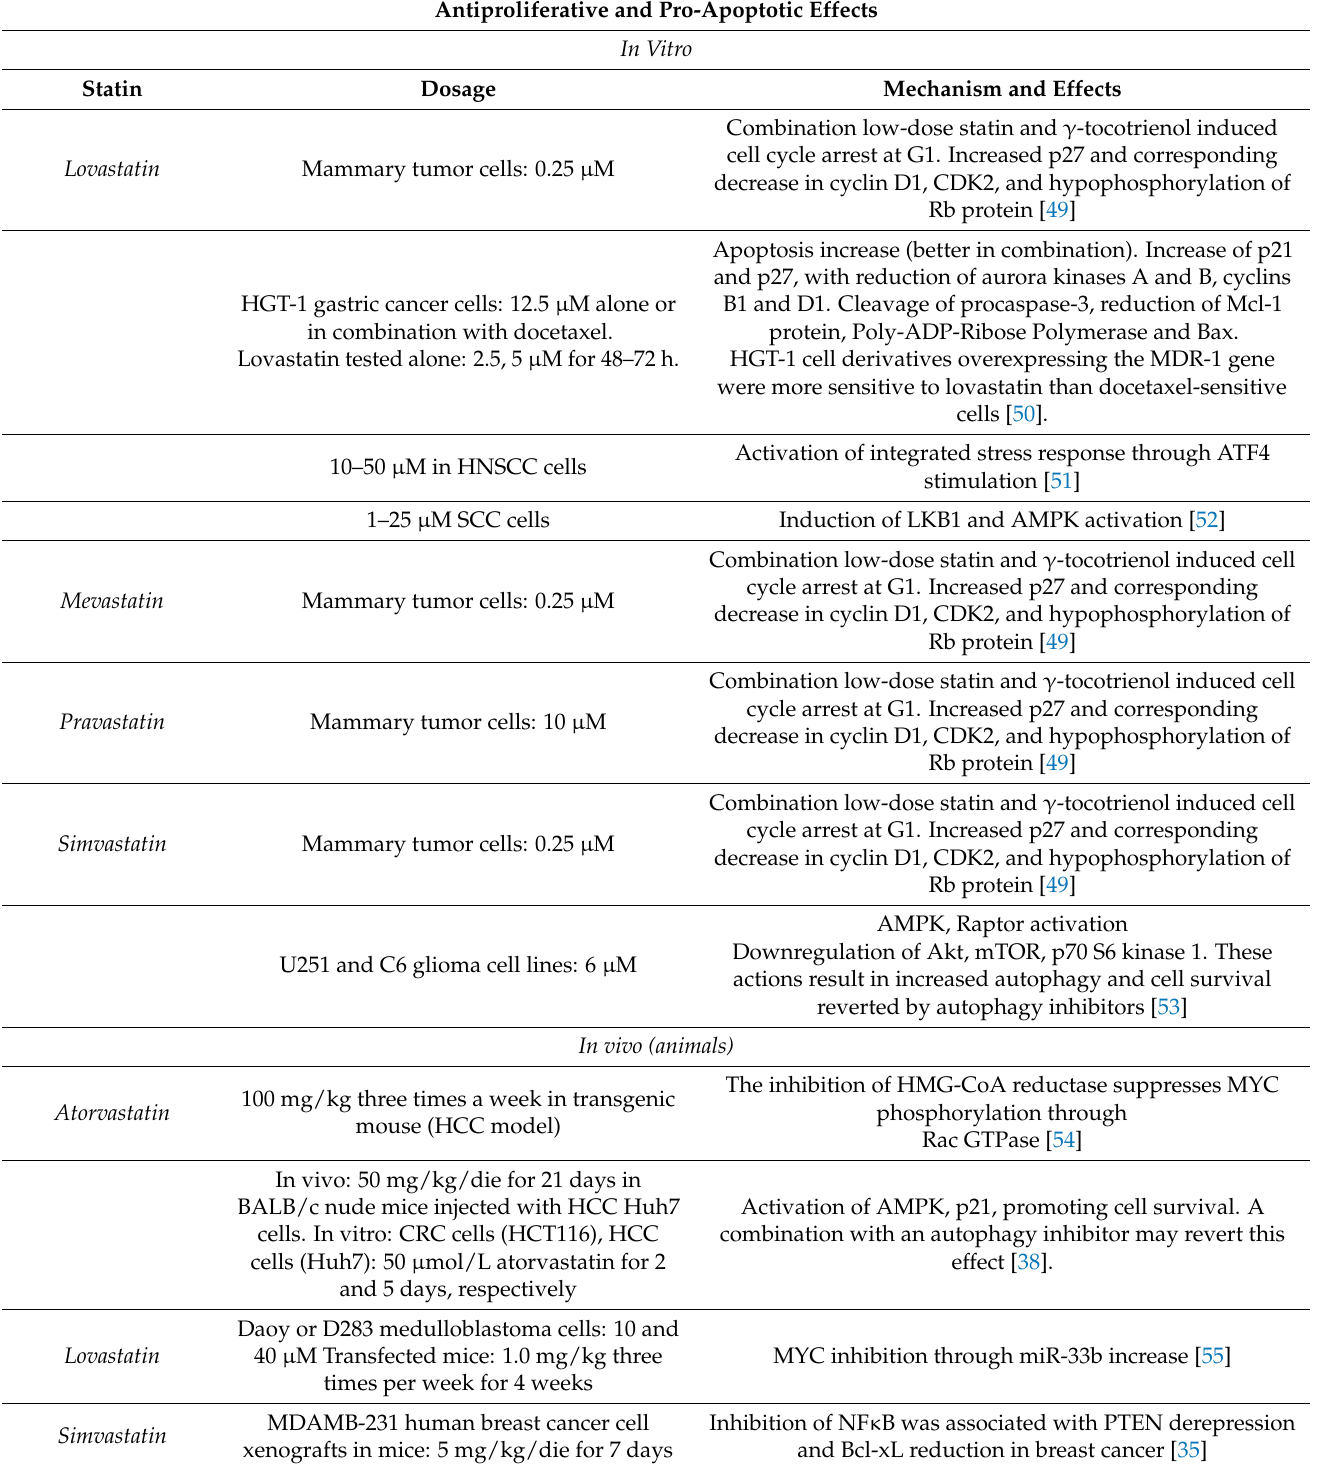
Table 4. Statins’ possible antiproliferative and pro-apoptotic effects (further studies